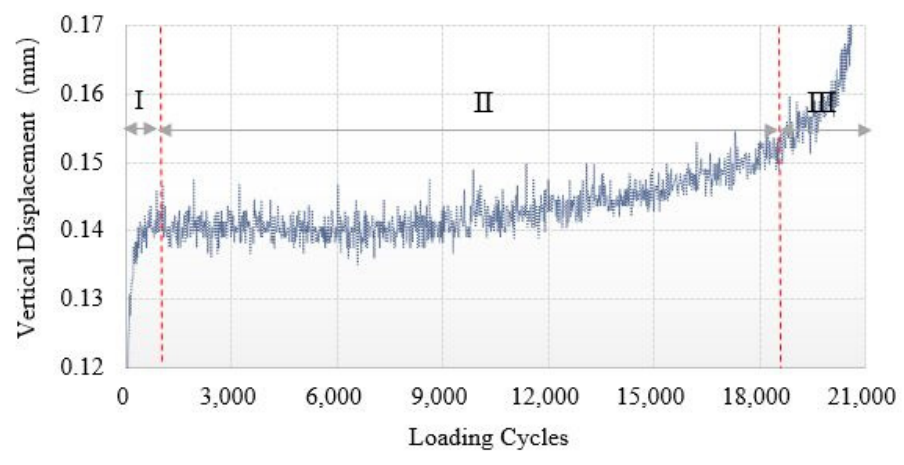
Figure 5. Three stages of ECC fatigue cracking process during the SCB test under stress ratio 0.5.